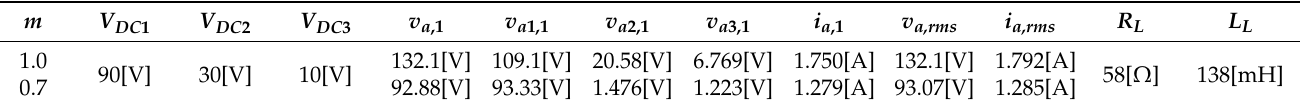
Table 3. Experimental parameters.